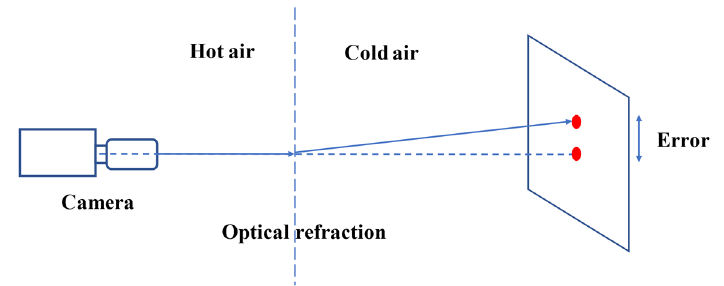
Figure 4. Principle of optical refraction error.